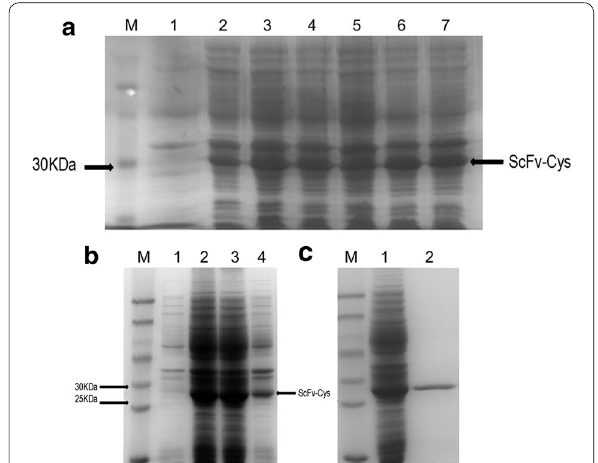
Fig. 2 Inducible expression and purification of rScFv-Cys. a SDS-PAGE analysis of rScFv-Cys. M, Marker. Lane 1, total bacterial protein without IPTG. Lane 2–7, total bacterial protein with IPTG induction. b SDS-PAGE analysis of different expression levels of rScFv-Cys in the supernatant and precipitation of bacterial. Lane 1, total bacterial protein without IPTG. Lane 2, total bacterial protein after induction. Lane 3, bacterial supernatant after induction; Lane 4, bacterial precipitation after induction. c SDS-PAGE analysis of rScFv-Cys purification (lane 1, before purification; lane 2, after